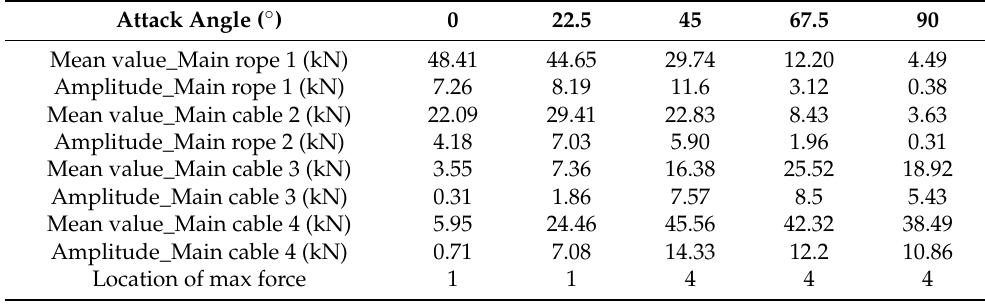
Figure 10. The schematic diagram of rope numbers and attack angles. Table 6. Mean values and amplitudes of the mooring forces on main ropes under different attack angles.